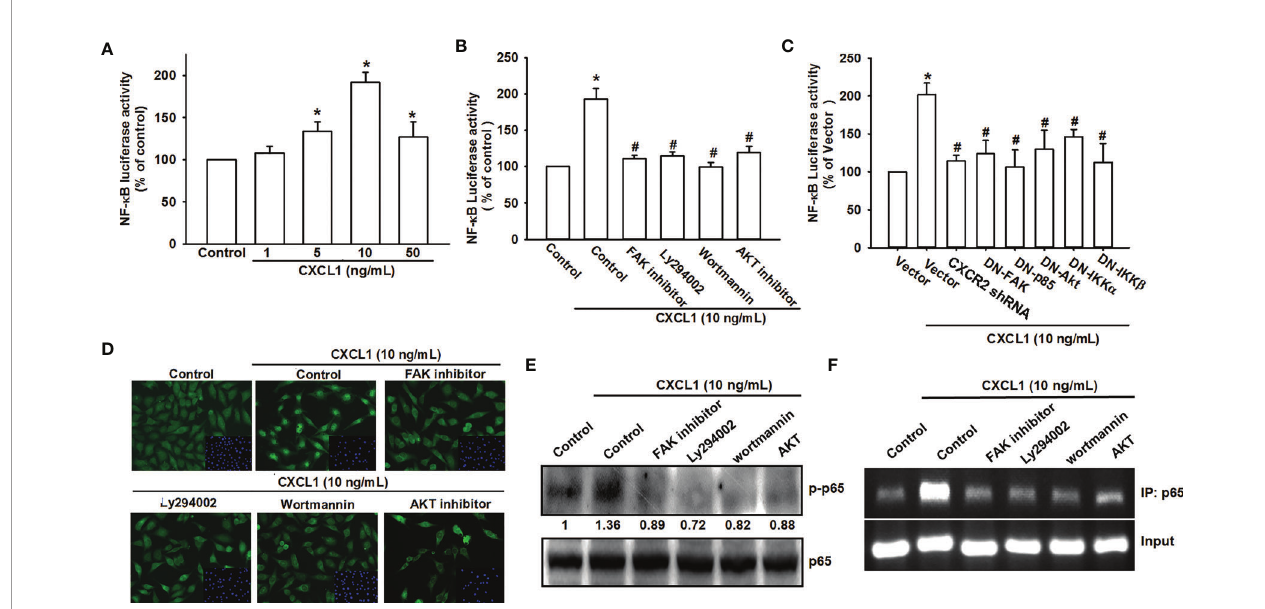
FIGURE 5 | NF- k B mediates the response of human osteosarcoma cells by CXCL1 stimulation. (A) The luciferase activity of NF- k B promoter plasmid was incubated with the indicated doses of CXCL1 for 24 h in MG63 cells. CXCL1 (1-50 ng/ml)-stimulated NF- k B luciferase activity was suppressed by (B) inhibitors of FAK, PI3K, and AKT and (C) dominant negative FAK, PI3K, AKT, IKK, or CXCR2 shRNA. (D) The anti-p65 and DAPI signals by pretreated several inhibitors and then CXCL1 (10 ng/ml)-stimulated, representative confocal microscopy images were shown. (E) CXCL1-induced p65 phosphorylation and (F) chromatin immunoprecipitation of anti-p65 in nuclear extracts of MG63 cells were measured with pretreated inhibitors. One percent of immunoprecipitated chromatin was assayed to verify equal loading (input). Results are expressed as the mean ± S.D. of triplicate samples. * p < 0.05 as compared to the control group; # p < 0.05 compared with the CXCL1-treated control or vector group.